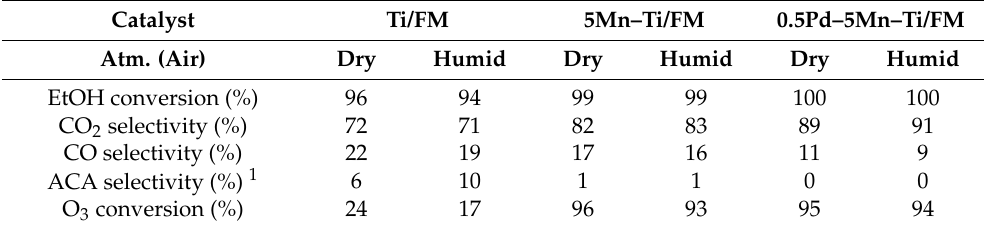
Table 4. Ethanol oxidation on the impregnated full monolithic catalysts (F M ) with 54 channels , in dry and humid air (10% RH) conditions (total flow rate = 500 mL · min − 1 , [EtOH] = 10 ppm, [O 3 ] = 70 ppm, T = 60 ◦ C, Time = 3